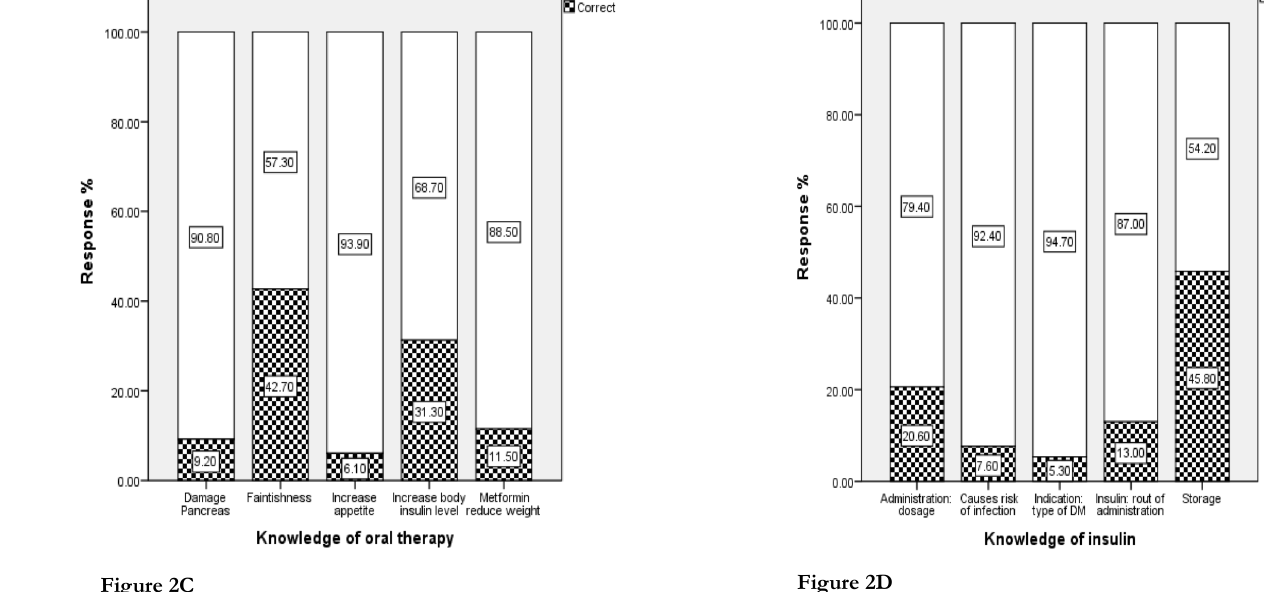
Figure 3A: Awareness and knowledge of diabetes- related complications.